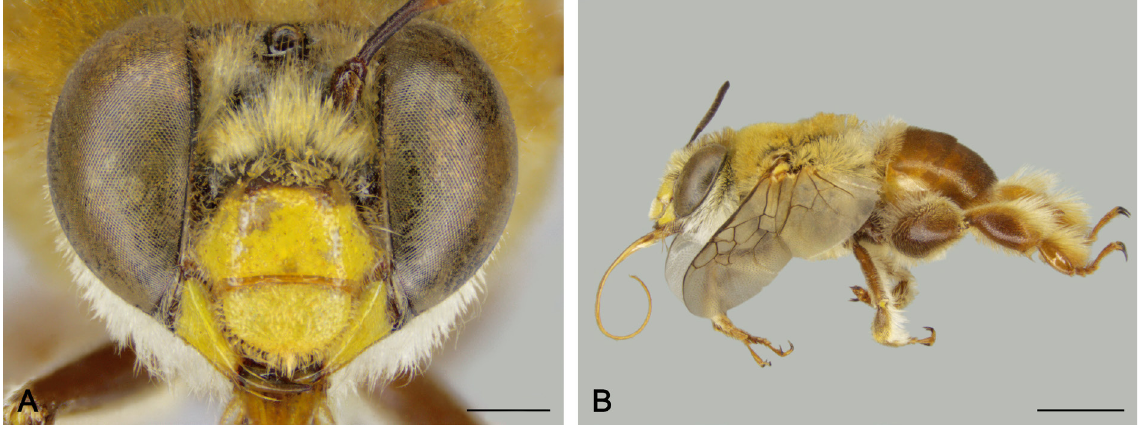
Fig. 3. Hemisia byssina Klug, 1808 (lectotype ♂). A . Frontal view. B . Habitus, lateral view. Scale bars: A = 0.5 mm; B = 2